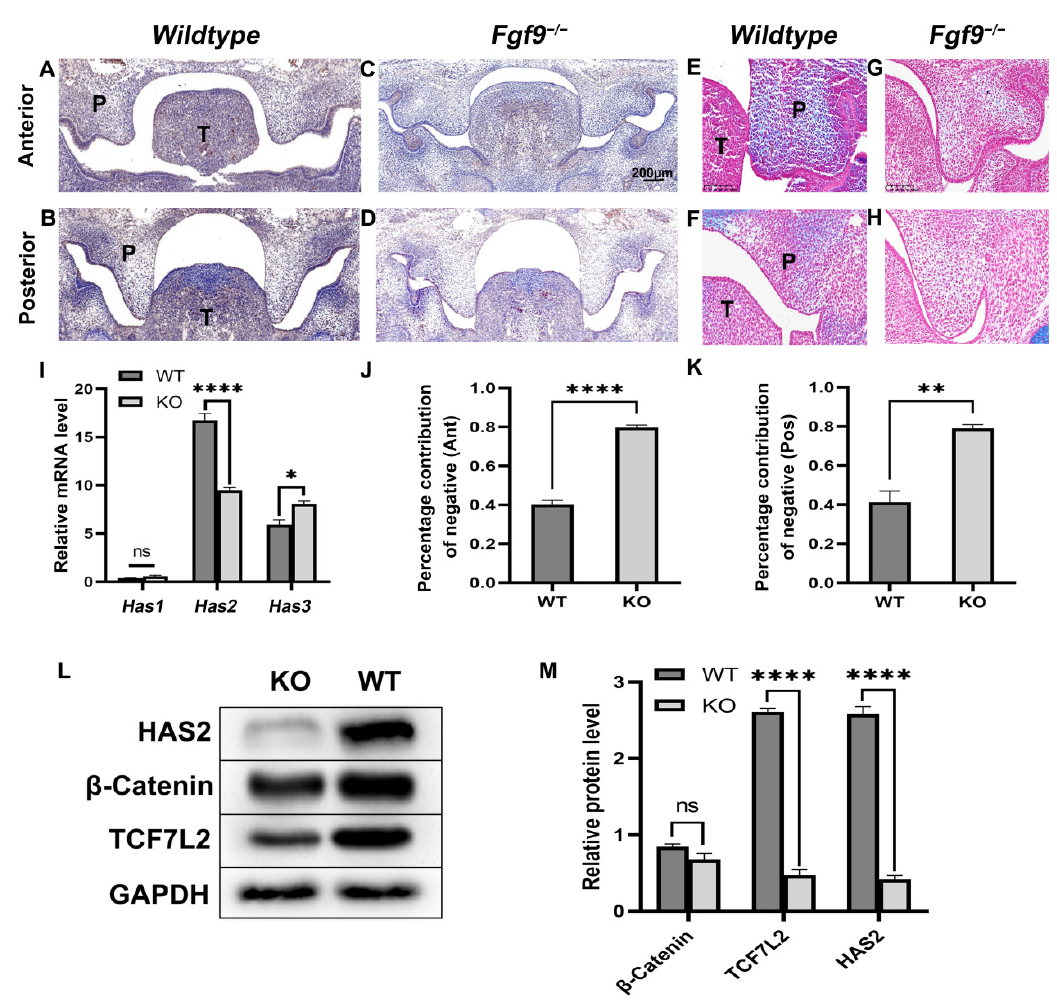
Figure 2. Analysis of HA and HAS2 expression in Wildtype and Fgf9 − / − palate at E13.5. ( A – D ) Expression of HAS2 in ( A , C ) anterior, and ( B , D ) posterior coronal sections of Wildtype ( A , B ) and Fgf9 − / − mutant ( C , D ) embryos. ( E – H ) Alcian blue-stained ( E , G ) anterior, and ( F , H ) posterior coronal sections of Wildtype ( F , F ) and Fgf9 − / − mutant ( G , H ) embryos. ( I ) The impact of the knockout Fgf9 on the mRNA level of Has1-3 was examined by a qRT-PCR experiment in vivo. ( J , K ) Wildtype and Fgf9 − / − ( J ) anterior, and ( K ) posterior palatal HAS2 expression was determined by quantification, and the proportion of IHC-negative cell was demonstrated. ( L , M ) Western blot analysis showed differences of HAS2, β -catenin, and TCF7L2 expression in Wildtype and Fgf9 − / − palate. The bar graph represents the mean ± SEM. ns: no significance, p ≥ 0.05, * p < 0.05, ** p < 0.01, **** p < 0.0001. P, palate. T, tongue.